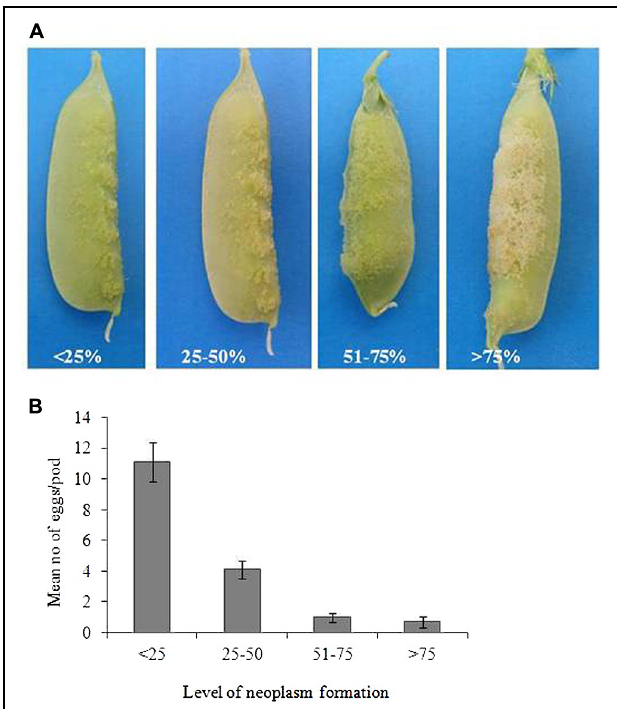
FIGURE 3 | (A) Illustration of the degree of neoplasm formation on pods of 235899-1 . (B) Mean number of eggs laid on pods of Np genotype with different level of neoplasm formation. Bars indicate mean ± standard error (SE).